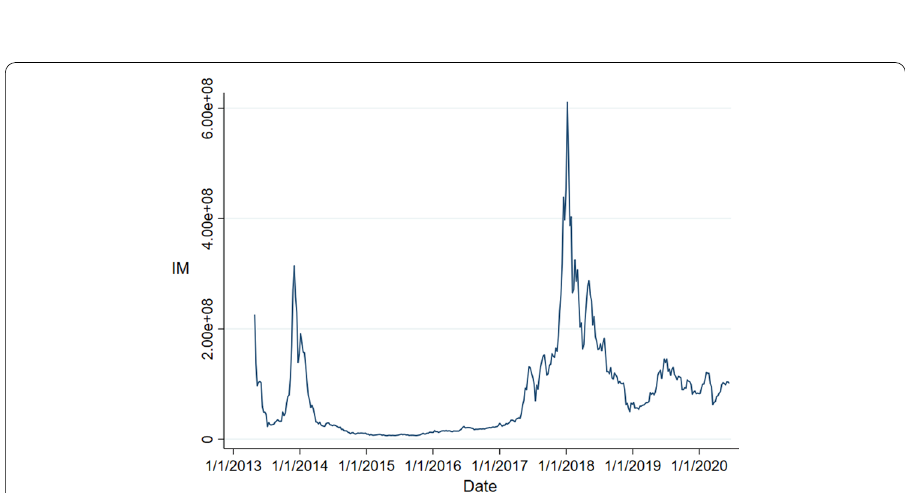
Fig. 2 Illustration of the market capitalization divided by the number of cryptocurrencies traded. Source : Own